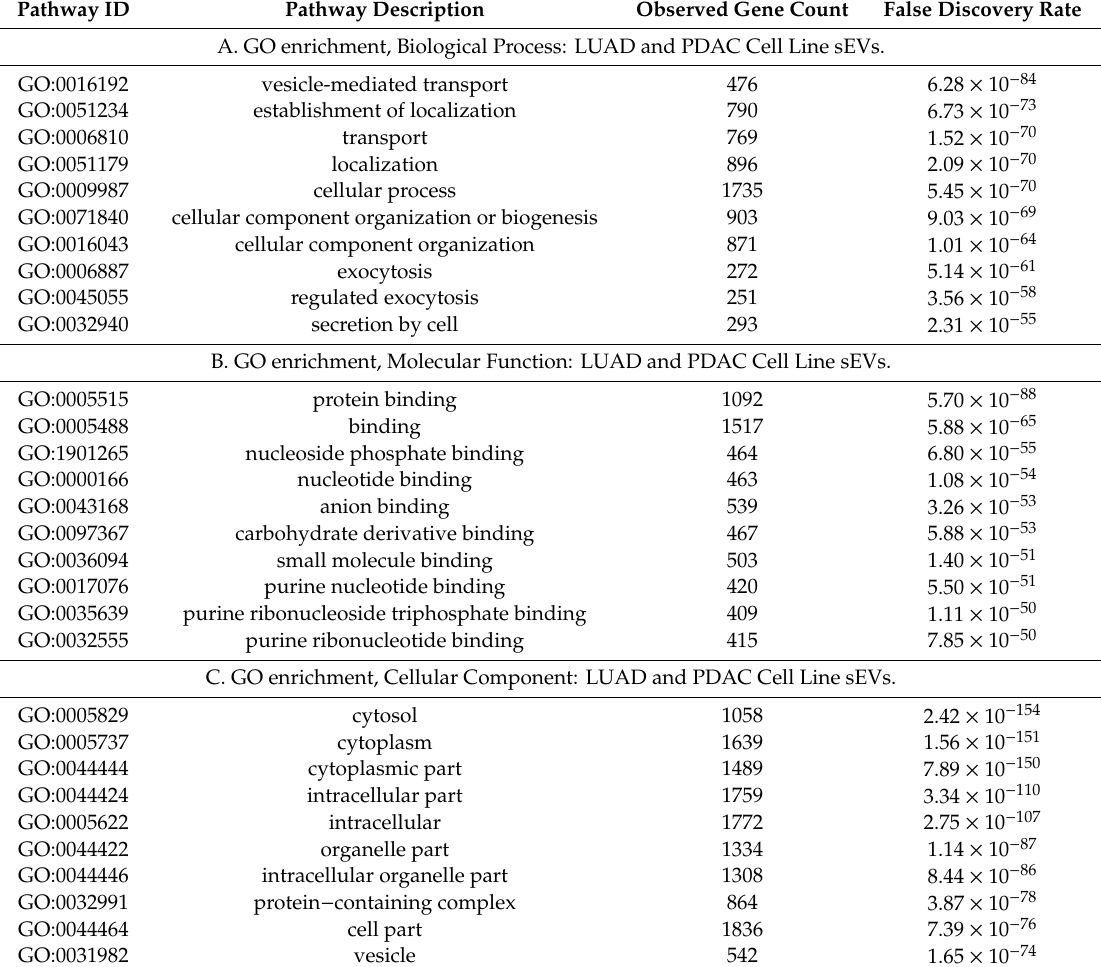
Table A1. STRING gene ontology (GO) enrichment analysis of sEV protein features identified in two or more adenocarcinoma panel (LUAD and PDAC) cell lines with ≥ 8 SA. Top ten statistically enriched Biological Process, Molecular Function and Cellular Component GO